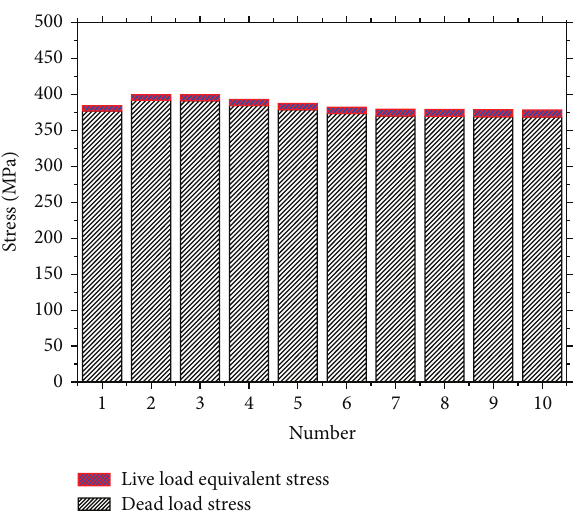
Figure 16: Equivalent stress of live load and dead